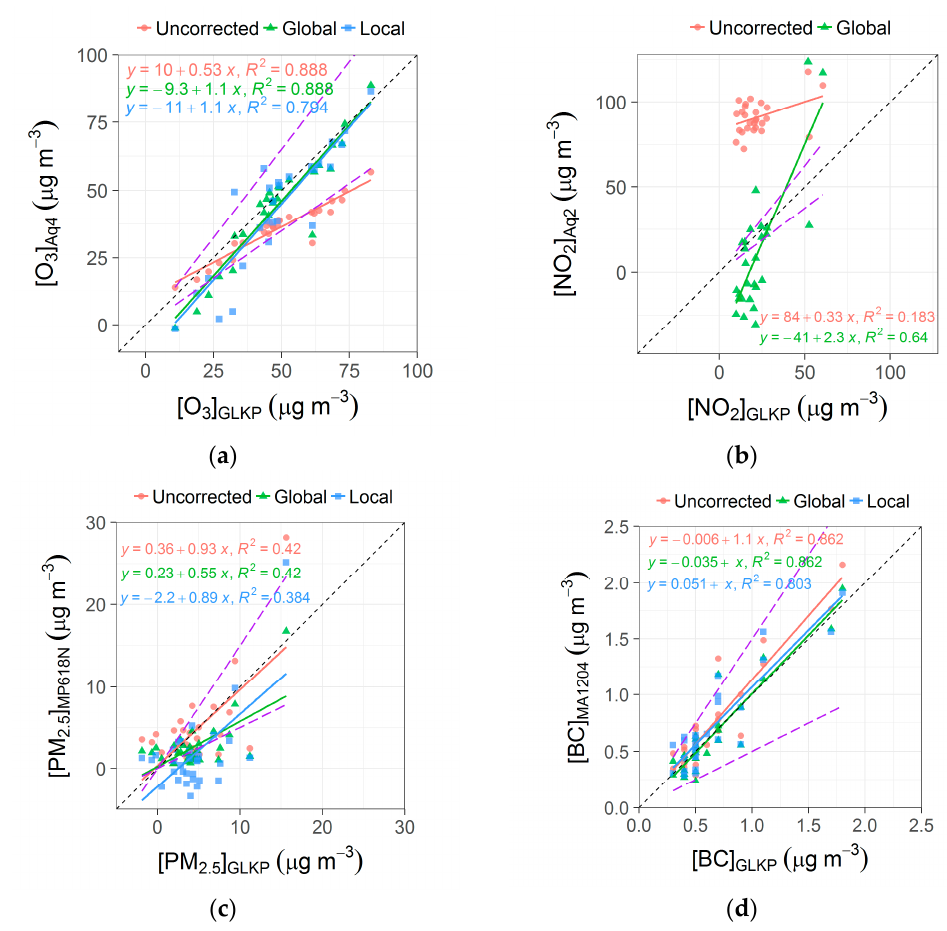
Figure 2. Portable monitor measurements collected during transient portable deployments standing by the AURN Glasgow Townhead reference analyser station for ( a ) the Aeroqual Aq4 O 3 monitor; ( b ) the Aeroqual Aq2 NO 2 monitor; ( c ) the MicroPEM MP618N PM 2.5 monitor, and ( d ) the microAeth AE51 MA1204 BC monitor. In all of the cases, concentration units are μ g m − 3 , the reference measurements are the ratified hourly averaged values, and the monitor measurements are the means of 1-min measurements within the corresponding reference analyser hour. In the majority of cases the transient co-location was shorter than 1 h, but always greater than 15 min; data in Tables S2–S5 indicate the duration of each separate co-location for the O 3 , NO 2 , PM 2.5 , and BC portable monitor transient data collections, respectively. The outer pair of dashed lines in each panel demarcate, respectively, ±30%, ±25%, ±50%, and ±50% from the 1:1 line as guides to expectations of ‘indicative’ measurements for O 3 , NO 2 , PM 2.5 , and BC (see text for further details).